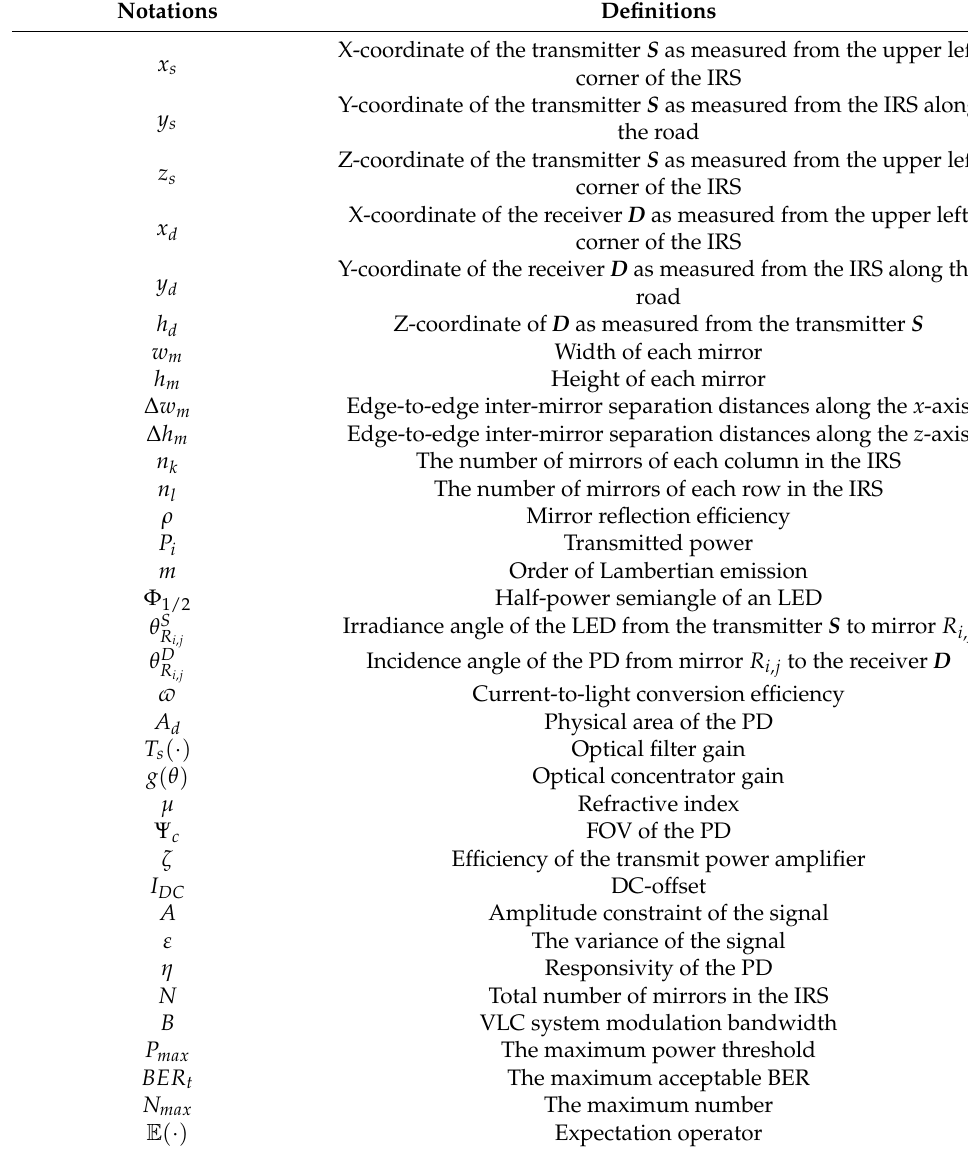
Table 1. Mathematical notations and